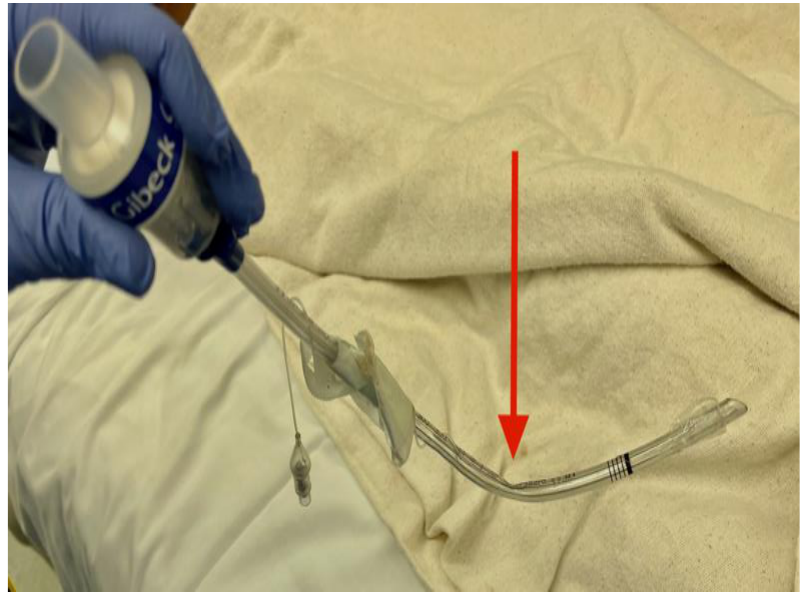
Figure 1. Endotracheal tube removed from patient with kink found at 11cm. Red arrow depicts site of kink.